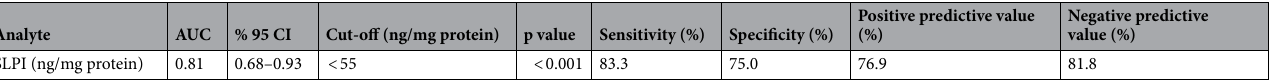
Table 4. AUC and cut-off value for normalized salivary SLPI levels to identify periodontitis (comparing periodontitis to periodontal health). Positive and negative predictive values were given as percentage and p values are calculated by χ 2 test. AUC area under the curve, CI confidence interval, SLPI secretory leukocyte protease inhibitor, ng nanogram, mg